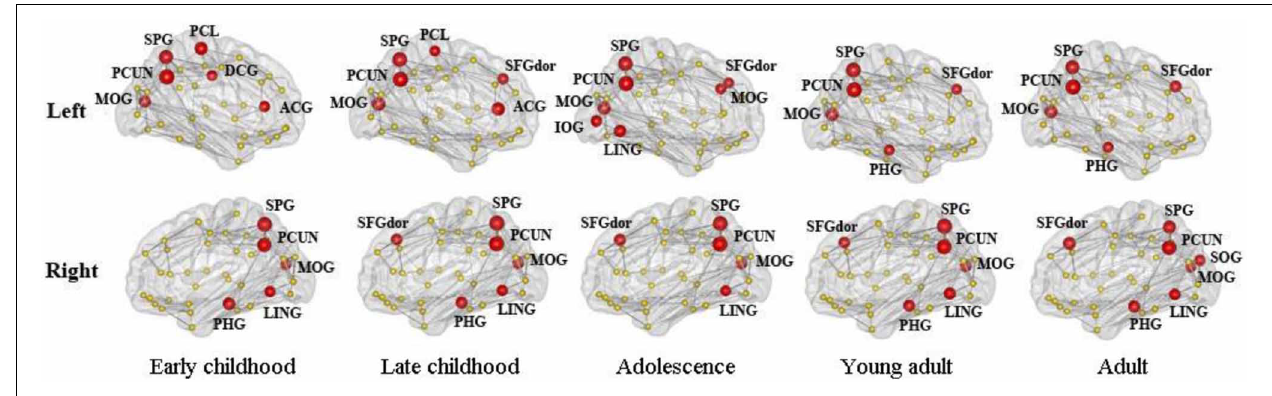
FIGURE 8 | The distribution of inter-modular hubs based on participation coefficient (PC) of each region for different age groups. They were mostly located within posterior cortex, including